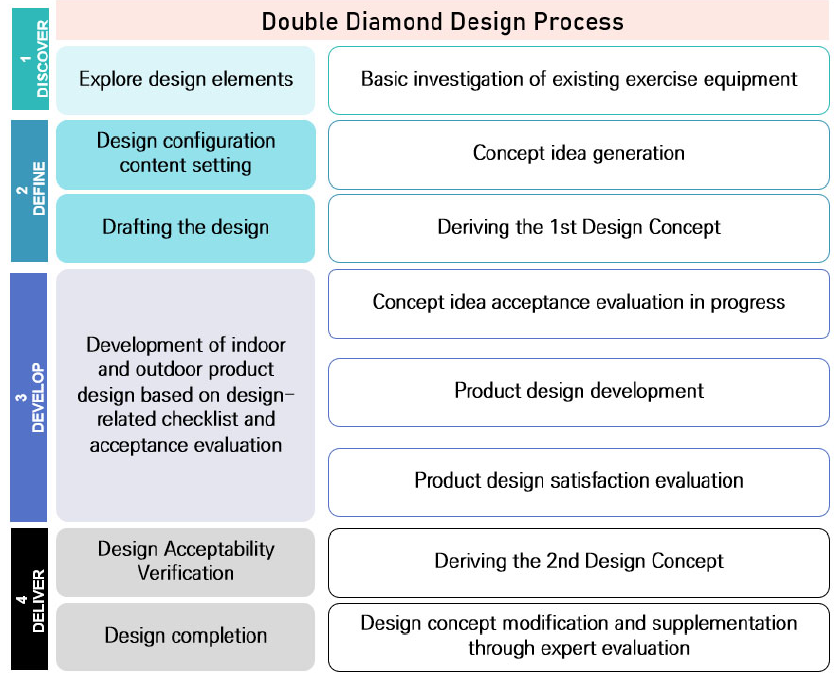
Figure 2. Research procedure.